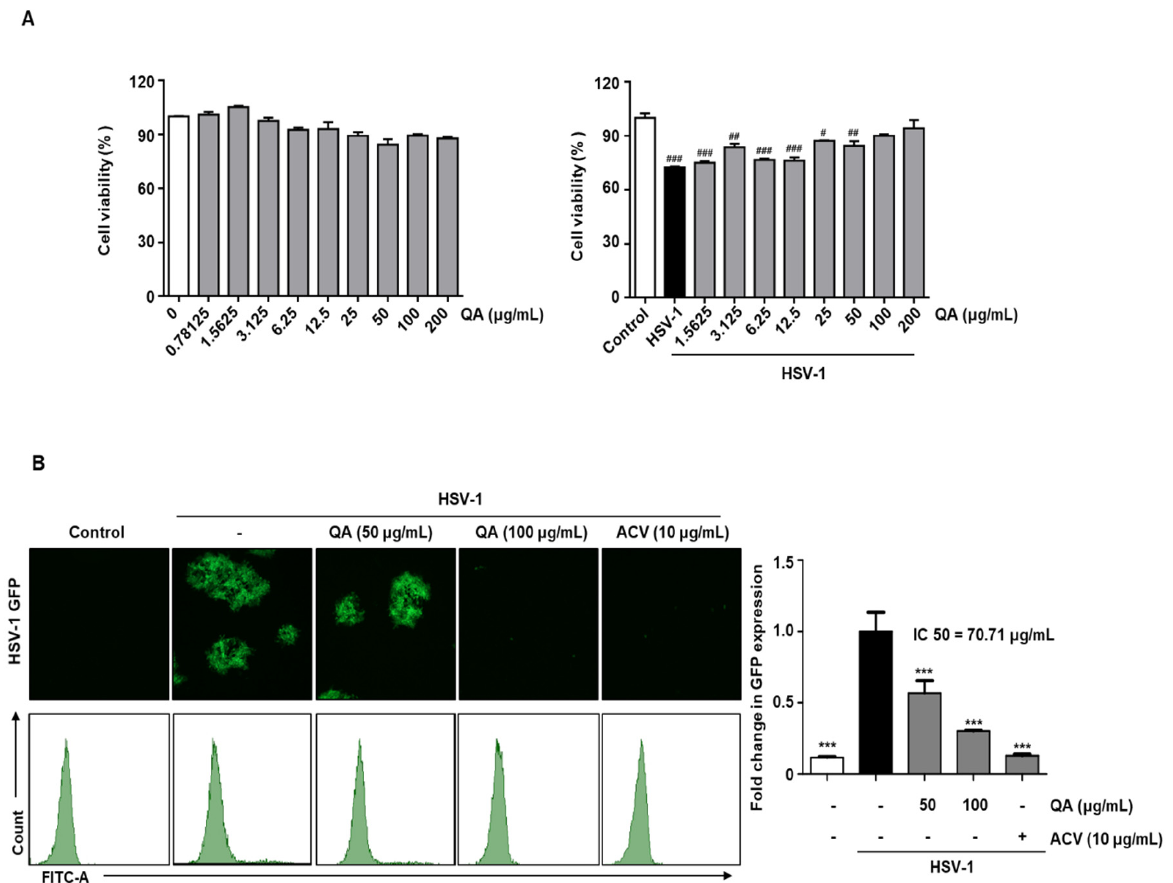
Figure 3. QA exhibits antiviral effects upon infection with HSV-1 in SK-N-SH cells. ( A ) SK-N-SH cells were treated with QA at the indicated concentrations for 48 h (left). SK-N-SH cells were infected with HSV-1 strains (MOI = 0.01) for 2 h and then treated with QA at the indicated concentrations for 48 h (right). Cell viability was measured by CCK-8 assay. ( B ) SK-N-SH cells were infected with HSV GFP (MOI = 2) for 2 h and then treated with QA (50 and 100 µg/mL) for 48 h. HSV GFP expression levels were analyzed by fluorescence microscopy (left) and flow cytometry (right). The data are representative of three independent experiments and quantified as mean values ± SEM. One-way ANOVA with Tukey’s post hoc test; # p < 0.05, ## p < 0.01, ### p < 0.001, compared with the control. *** p < 0.001, compared with the HSV-1treatment. IC50; The half maximal inhibitory concentration.